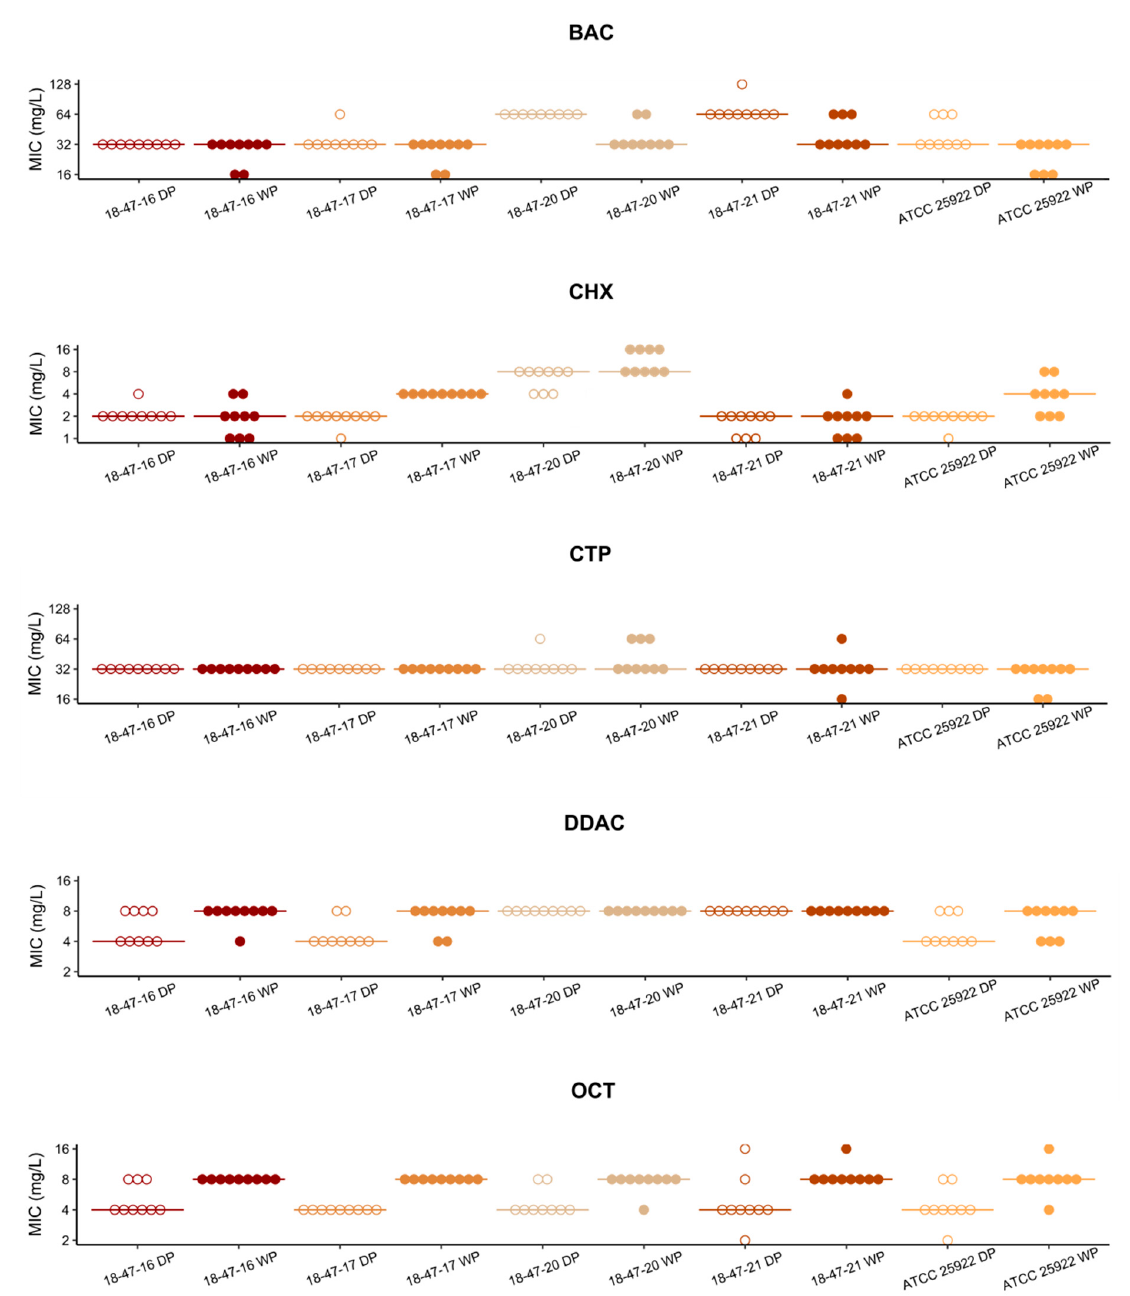
Figure 2. Susceptibility of five Escherichia coli strains to cationic biocides. Minimum inhibitory concentrations of benzalkonium chloride (BAC), chlorhexidine dihydrochloride (CHX), cetylpyridinium chloride (CTP), didecyldimethylammonium chloride (DDAC), and octenidine dihydrochloride (OCT) determined by wet plate procedure (WP; filled dots) and dried plates (DP; empty dots) are shown. Lines represent the respective modal values.